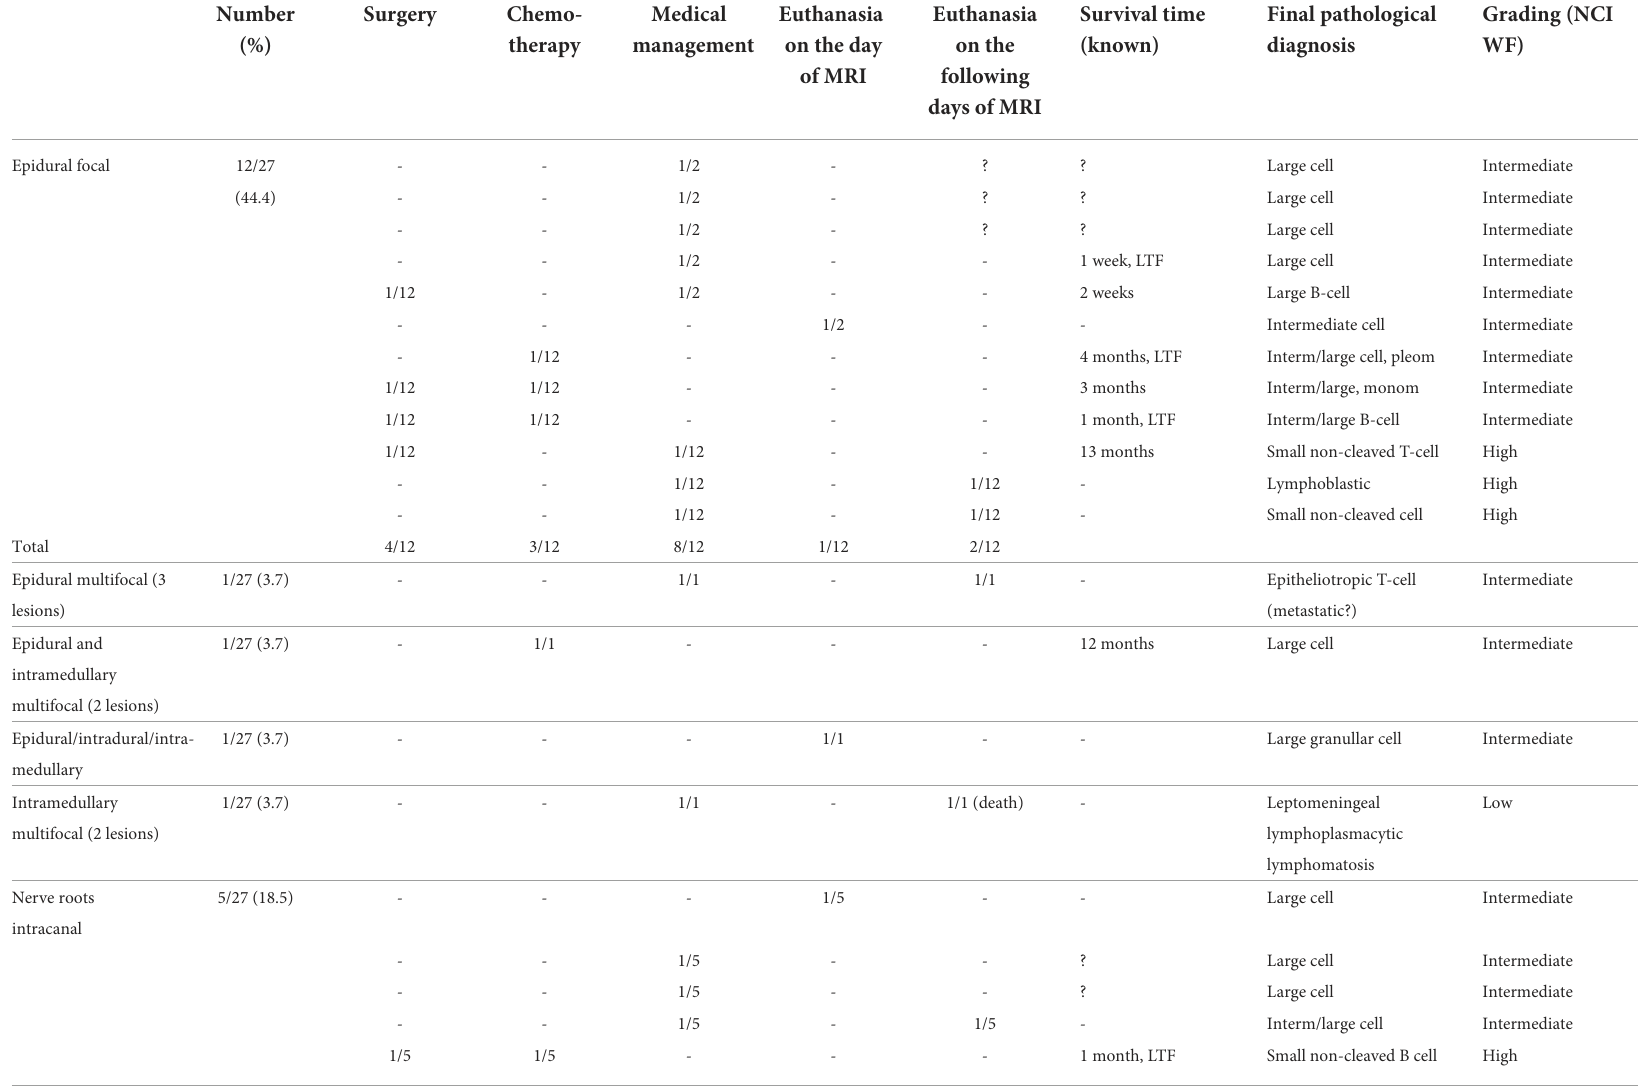
TABLE 6 Treatment and survival time in 27 cats with spinal